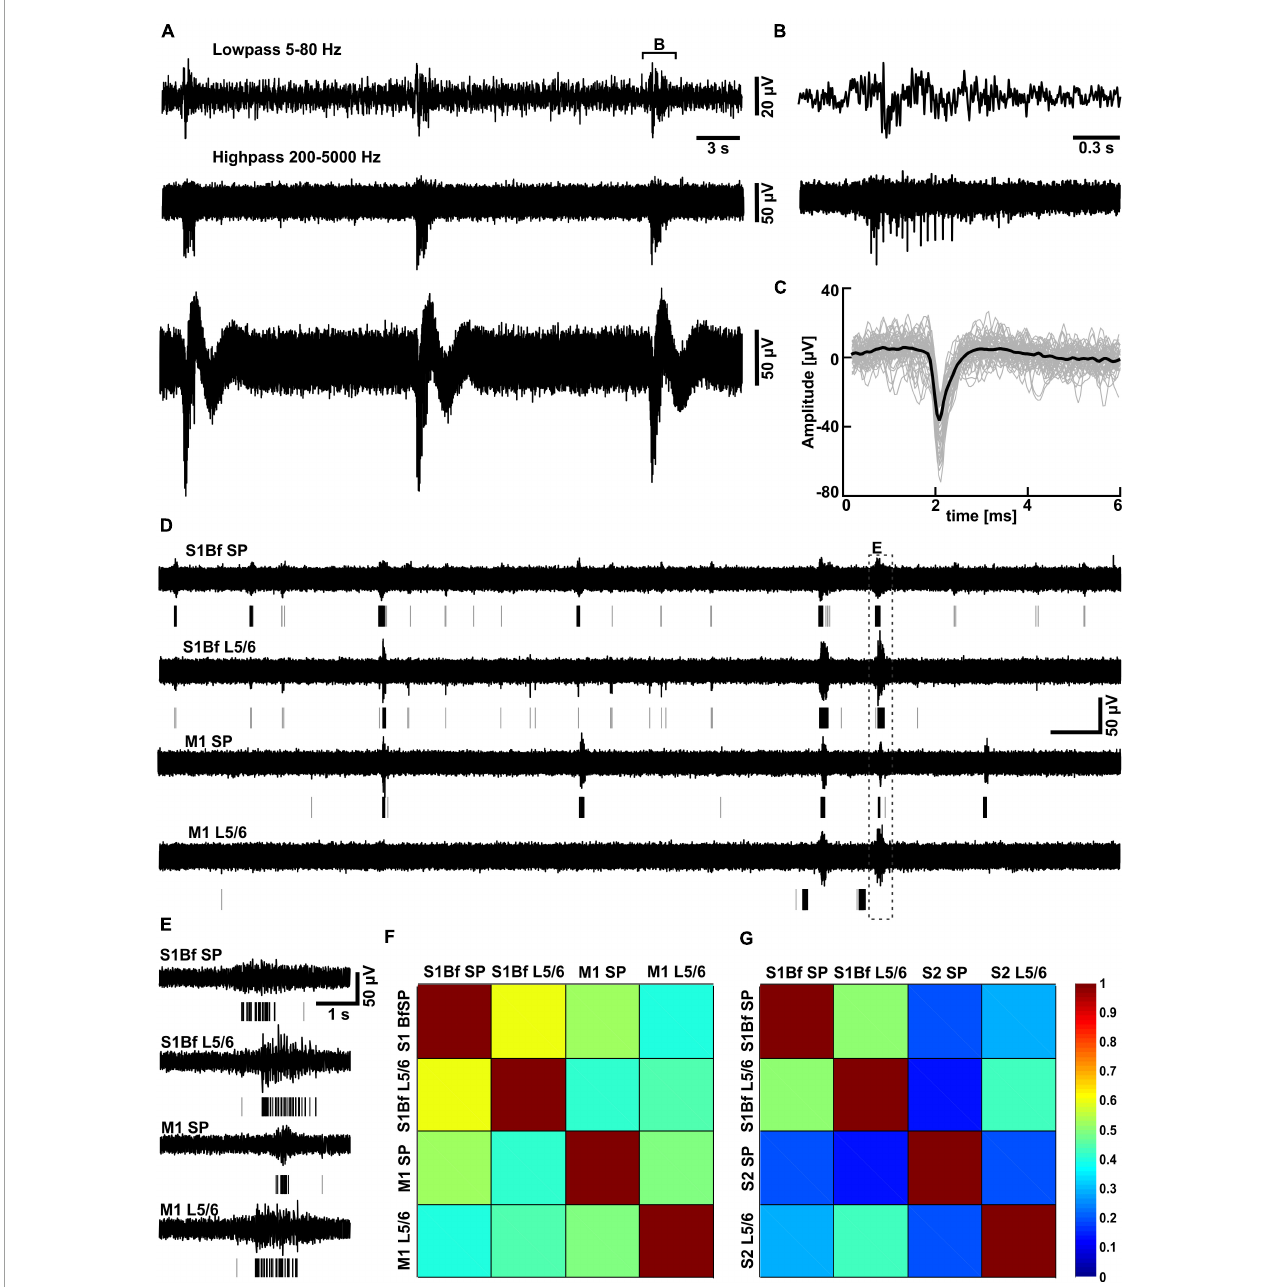
FIGURE5 Partially correlated discontinuous multiunit activity in low Mg 2 + -ACSF. (A) Typical trace recorded with one MEA electrode located in L5/6 of S1Bf. Above the trace the highpass-filtered signal used for the spike detection and the lowpass-filtered signal are displayed. (B) Representative interval of a burst as depicted in panel (A) . (C) Plot of individual spikes identified by the threshold-crossing detector (gray traces) and the average spike waveform (black trace). (D) Simultaneous recording of multi-unit activity (MUA) in the subplate (SP) and in L5/6 of S1Bf and M1 recorded in low Mg 2 + ACSF. The lines beneath the trace indicate identified spikes, isolated spikes are represented by gray lines, spikes belonging to a burst by black lines. Note the frequent occurrence of burst-like activity transients in all areas and that burst like activity was only partially correlated between the investigated regions. (E) Representative interval of a burst correlated between all electrodes [as indicated in panel (A) ] illustrating a significant delay in the onsets of the bursts between the recordings. (F) The correlation matrix for electrode pairs inserted in S1Bf and M1 revealed that the bursts were only partially correlated between regions, with the highest degree of correlation observed between S1Bf SP and S1 L5/6 and the lowest degree of correlation between S1Bf SP and M1 L5/6. (G) Correlation matrix for electrode pairs inserted in S1Bf and S2. Note the overall lower degree of correlation between S1Bf and S2 as compared to S1Bf–M1